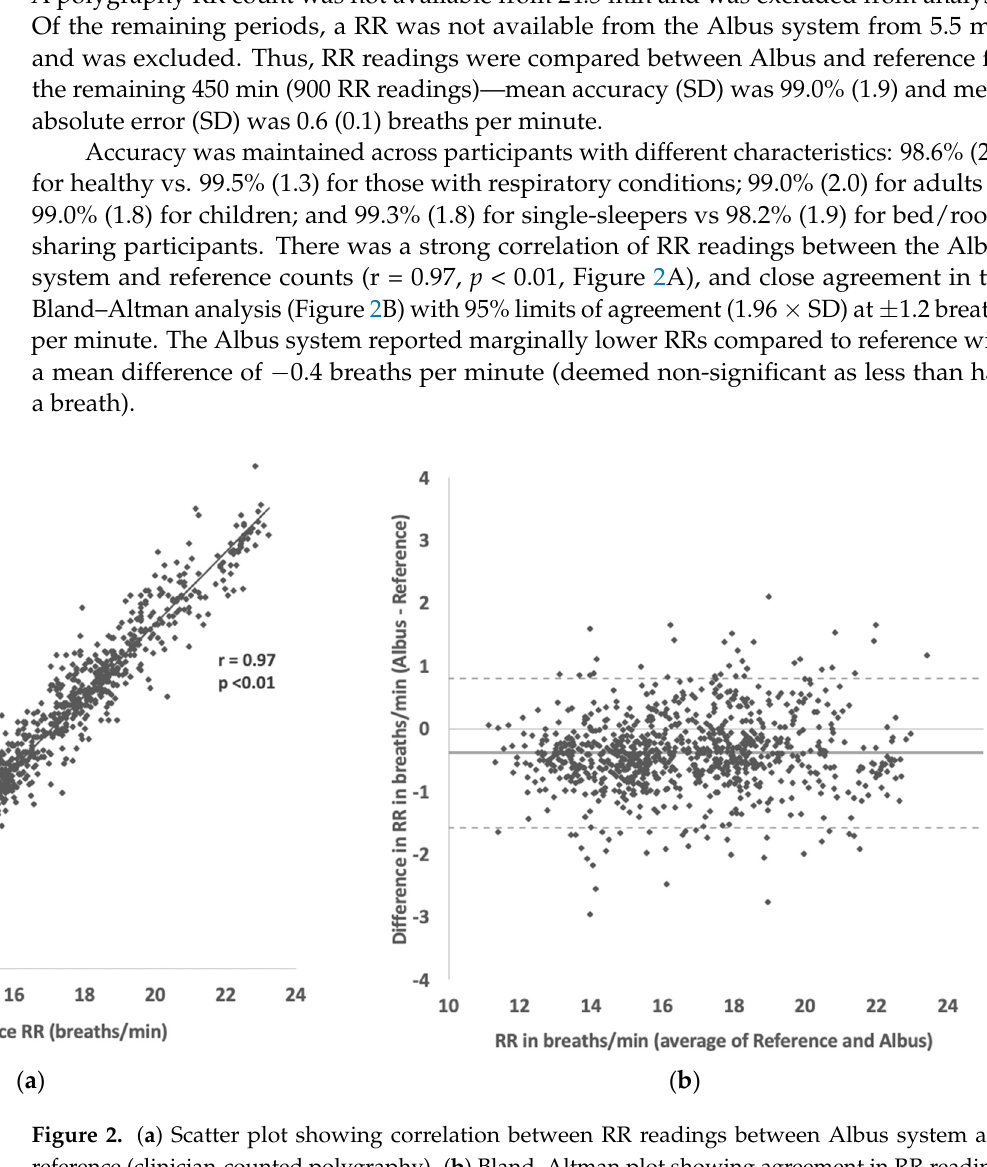
( b ) Figure 3. ( a ) Scatter plot showing correlation between hourly mean RR readings between Albus system and reference (clinician-counted polygraphy). ( b ) Bland–Altman plot showing agreement in hourly mean RR readings between Albus system and reference (solid line shows mean difference of − 0.46 breaths/min and dotted lines show 95% limits of agreement from 0.04 to − 0.88 breaths/min). There are, in total, 20 comparisons across 10 participants, with each point depicting a mean RR reading for a 1-h period.